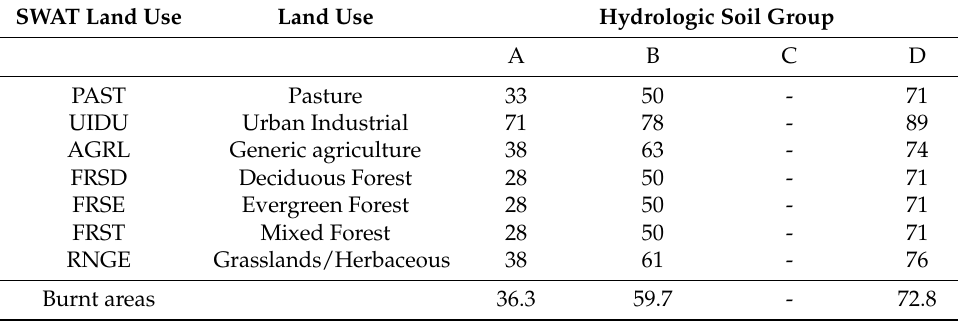
Table 2. The values of CN II obtained through the calibration process of SWAT. SWAT Land Use Land Use Hydrologic Soil Group A B PAST Pasture Urban Industrial Generic agriculture